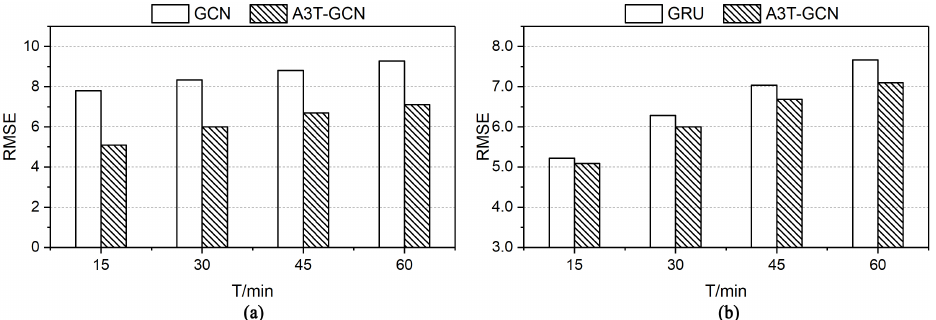
Figure 3. Los-loop: Effectiveness of modeling both spatial and temporal dependencies. ( a ) The RMSE comparison between the A3T-GCN and the GCN (captures spatial features only). The outperformance of the A3T-GCN under various prediction horizons verifies the effectiveness of the A3T-GCN in capturing additional temporal features compared with the GCN. ( b ) The RMSE comparison between the A3T-GCN and the GRU (captures temporal features only). The outperformance of the A3T-GCN under various prediction horizons verifies the effectiveness of the A3T-GCN in capturing additional spatial features compared with GRU.